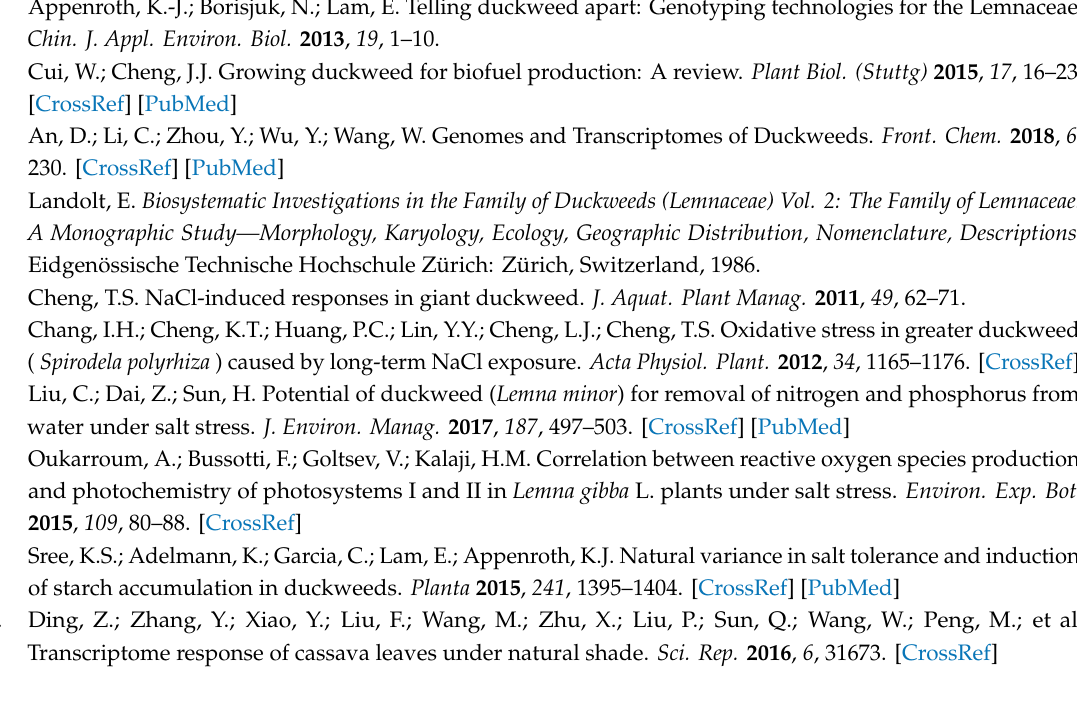
Figure S1. Performances of S. polyrhiza L. inoculated on medium conatining 50, 100, and 150 mM NaCl. Days after treatments are indicated on the right of each photos. Red arrows indicated discolorated plants. Figure S2. Heatmap of genes related to abiotic stress. These genes were grouped into three main clusters (A1-A3) according to their expression patterns. Blue and red cells (from left to right) represent log2-transformed FPKM values from 0, 6, 12, and 24 h after salt treatment, respectively. Table S1. Summary of 2156 DE genes identified in response to salt stress. Table S2. Summary of DE genes related to photosynthesis. Table S3. Summary of DE genes related to sucrose and starch biosynthesis -degradation pathways. Table S4. Summary of DE genes related to cell wall. Table S5. Summary of DE genes related to abiotic stress. Table S6. A list of 61 hormone related DE genes in this study. Table S7. A list of 106 di ff erentially expressed TFs. Table S8. Species and strains used in salt stress related papers. Table S9. qRT-PCR results and the primers used in this